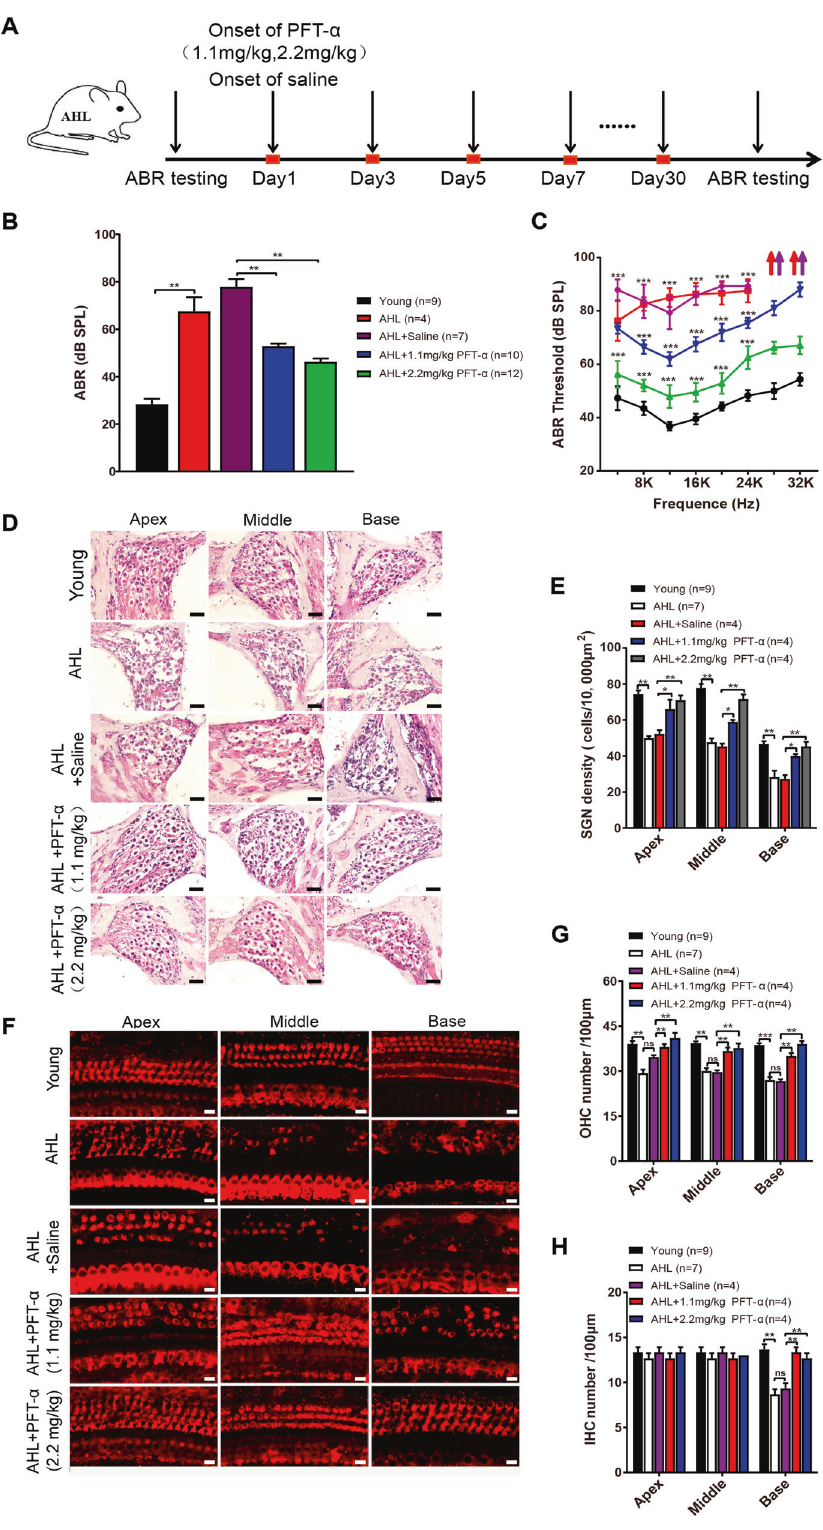
Fig. 7 p53 inhibitor pi fi thrin- α rescues the hearing loss in AHL mice. A Timeline for ABR testing and drug treatment. Pi fi thrin- α was administered to 8-month-old WT mice at 1.1 or 2.2 mg/kg every other day, for 30 days. B , C ABR thresholds in response to click ( B ) or pure-tone stimuli ( C ) were applied in Young, AHL, AHL + saline, AHL + 1.1 mg/kg pi fi thrin- α (PFT- α ), and AHL + 2.2 mg/kg (PFT- α ) mice. D , E Changes in SGN morphology and density in Young, AHL, AHL + saline, AHL + 1.1 mg/kg PFT- α , and AHL + 2.2 mg/kg PFT- α mice. F Immuno fl uorescence images showed alterations of HCs in mice in different treatment groups. G , H Quanti fi cation of OHCs ( G ) and IHCs ( H ) at the cochlea ’ s apical middle and basal regions in Young, AHL, and PFT- α treated mice. Scale bar: 20 µm in D, 10 µm in ( F ). Data are represented as mean ± SEM. ** P < 0.01, *** P <